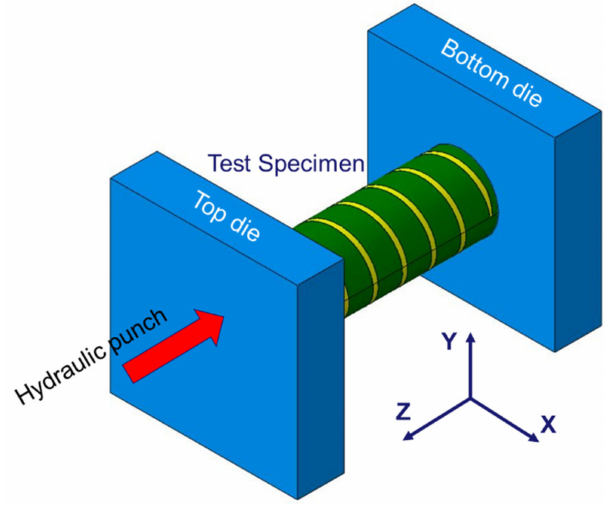
Figure 12. Model setup in FEM analysis.